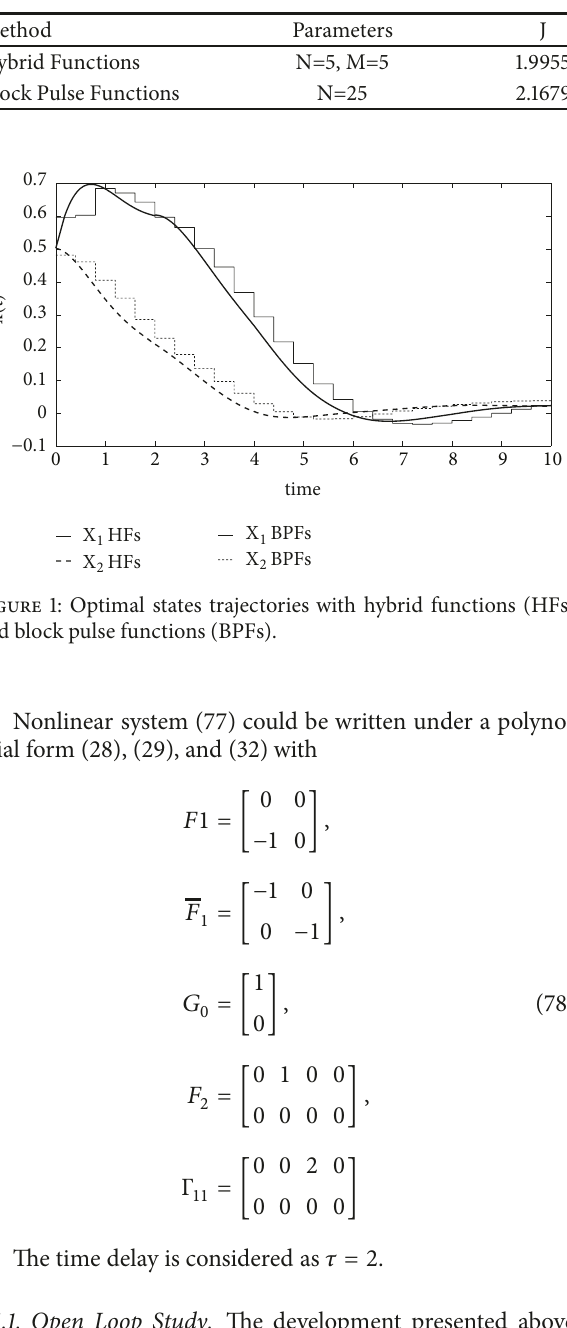
Table1:Hybridfunctionsandblockpulsefunctionsdirectapproach performance analysis for Example 1.